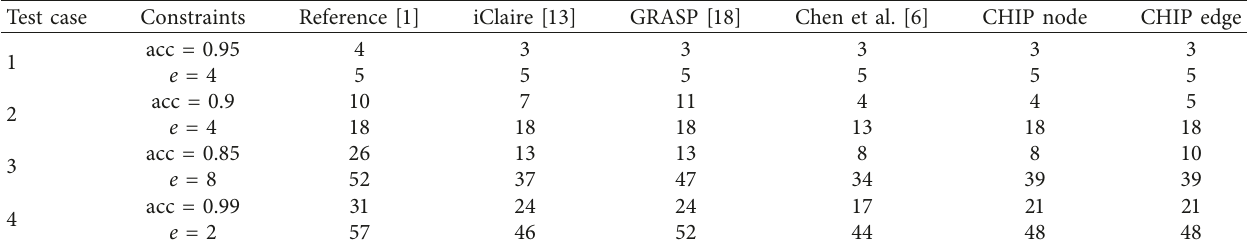
Table 4: Constrained clustering—comparison of CHIP v/s others (cluster